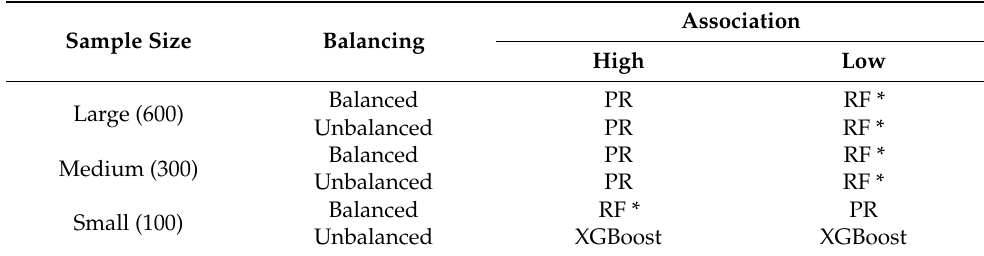
Table 5. Suggested guidelines for the choice of the classifier, according to sample size, balancing and association